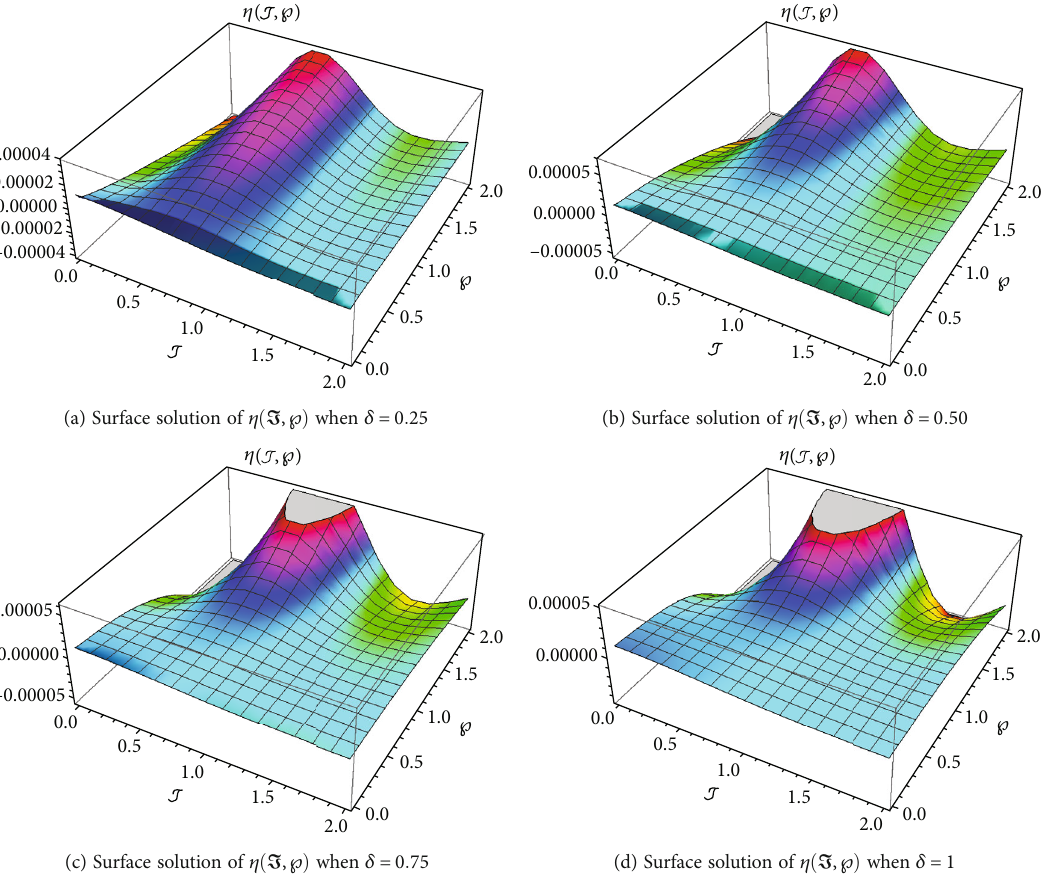
Figure 1: The surface solution of η ð I , ℘ Þ for distinct values of δ